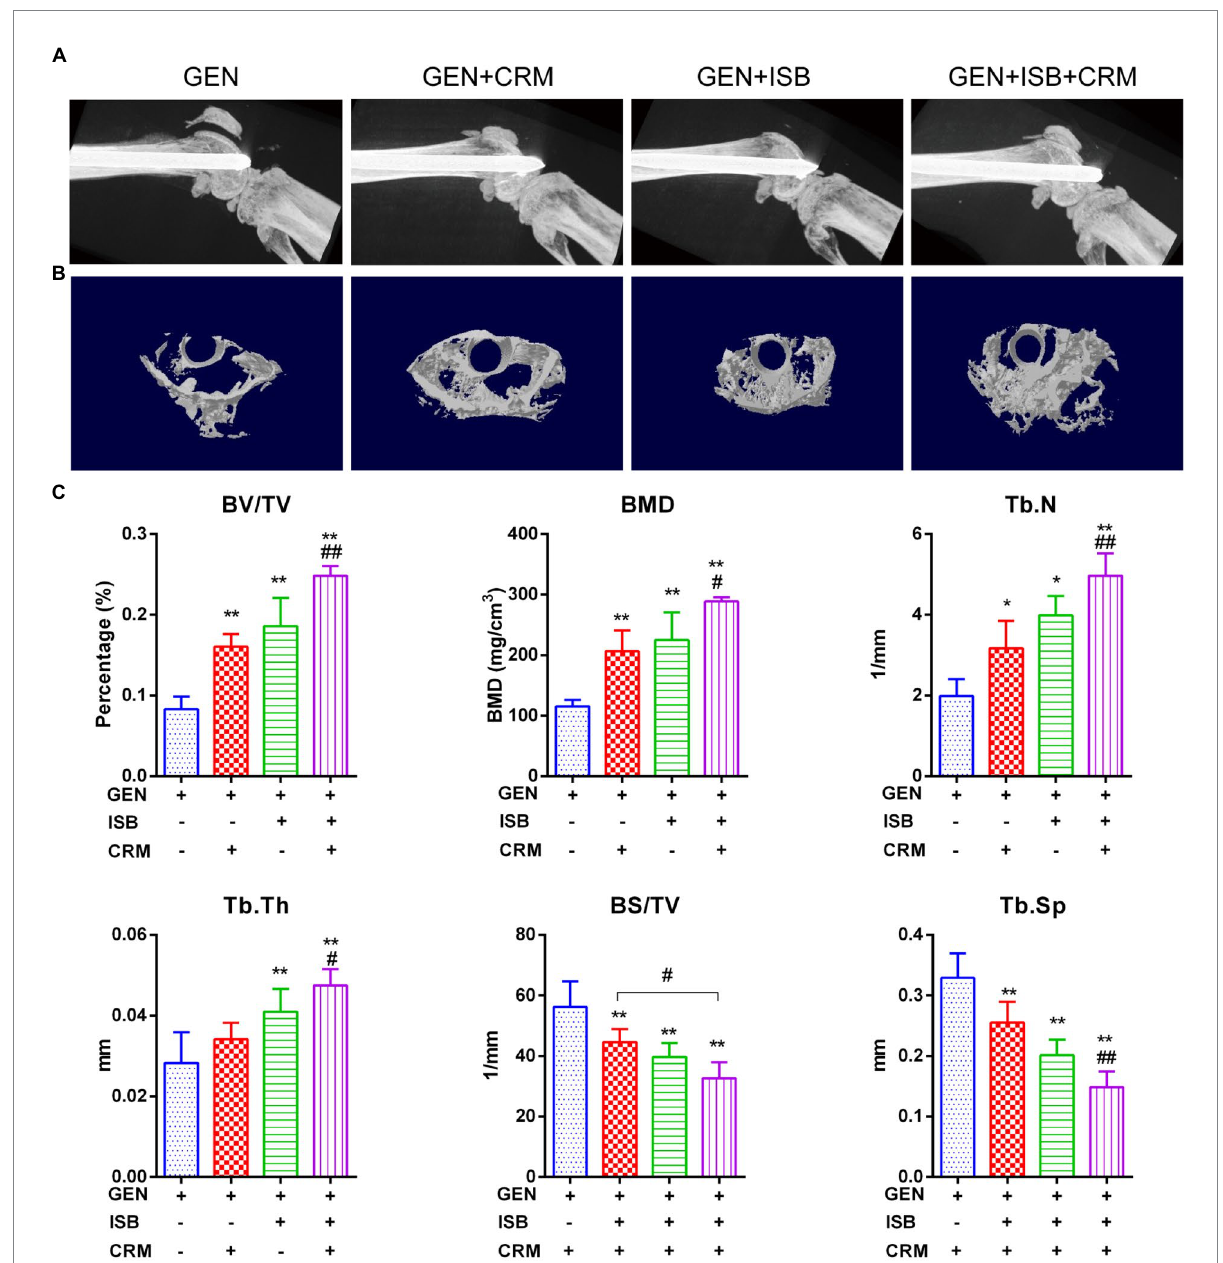
FIGURE 6 Micro Computed tomography ( μ CT) imaging suggests protection of cocktail therapy against osteolysis in orthopedic implant-related infections due to MRSA. (A) Representative X-ray images of distal femur of mouse with intramedullary implant. (B) Representative images of trans axial 3D reconstructed micro-architecture of distal femur around implant. (C) Bone morphometry in distal femur shows protection of combination of Isobavachalcone and Curcumin against osteolysis during orthopedic implant-related infection, related parameters including percent bone volume (BV/TV), trabecular thickness (Tb.Th), trabecular number (Tb.N), and trabecular separation (Tb.Sp), bone mineral density (BMD) and bone surface density (BS/TV) were measured, data were presented as mean ± SD, * represents p < 0.05 and ** represents p < 0.01 when compared to Gentamicin group; # represents p < 0.05 and ## represents p < 0.01 when GEN + ISB + CRM group compared to GEN + ISB/CRM group; GEN, 20 mg/kg/day Gentamycin; ISB, 20 mg/kg/day Isobavachalcone; CRM, 20 mg/kg/day